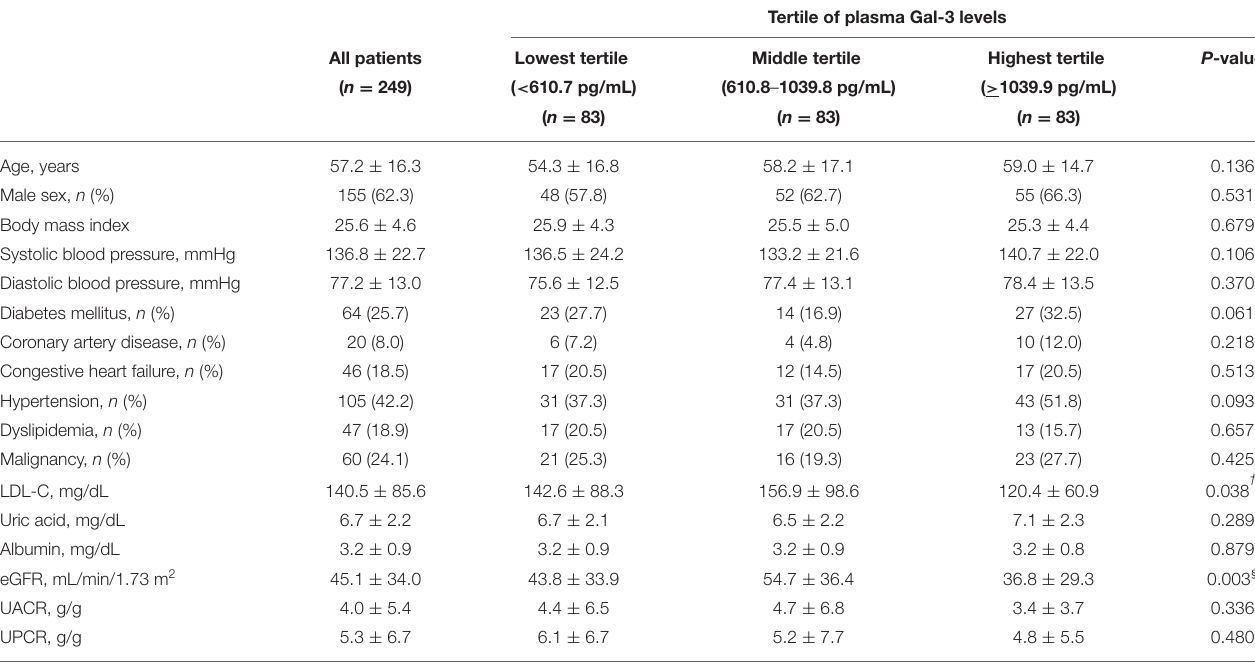
TABLE 1 | Clinical characteristics of our study participants stratified by tertile of plasma Gal-3